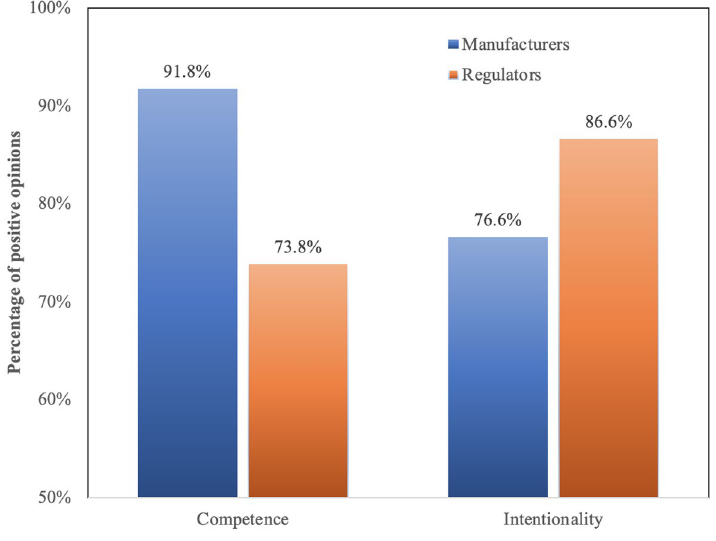
Figure 1. Beliefs on competence and intentionality of manufacturers and regulators regarding COVID-19